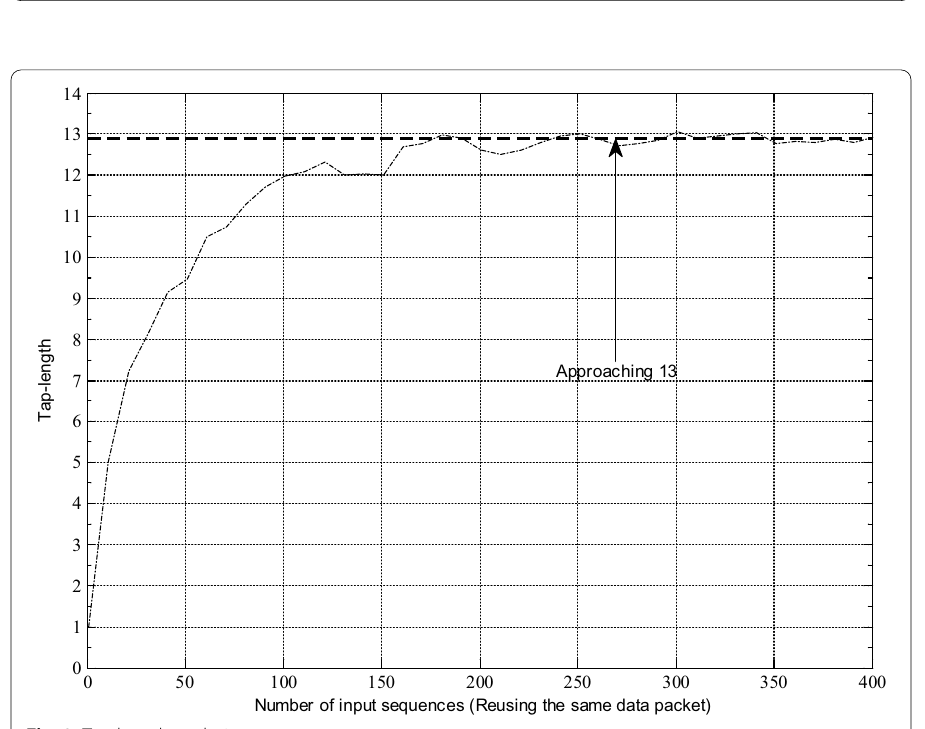
Fig. 3 Tap-length evolution